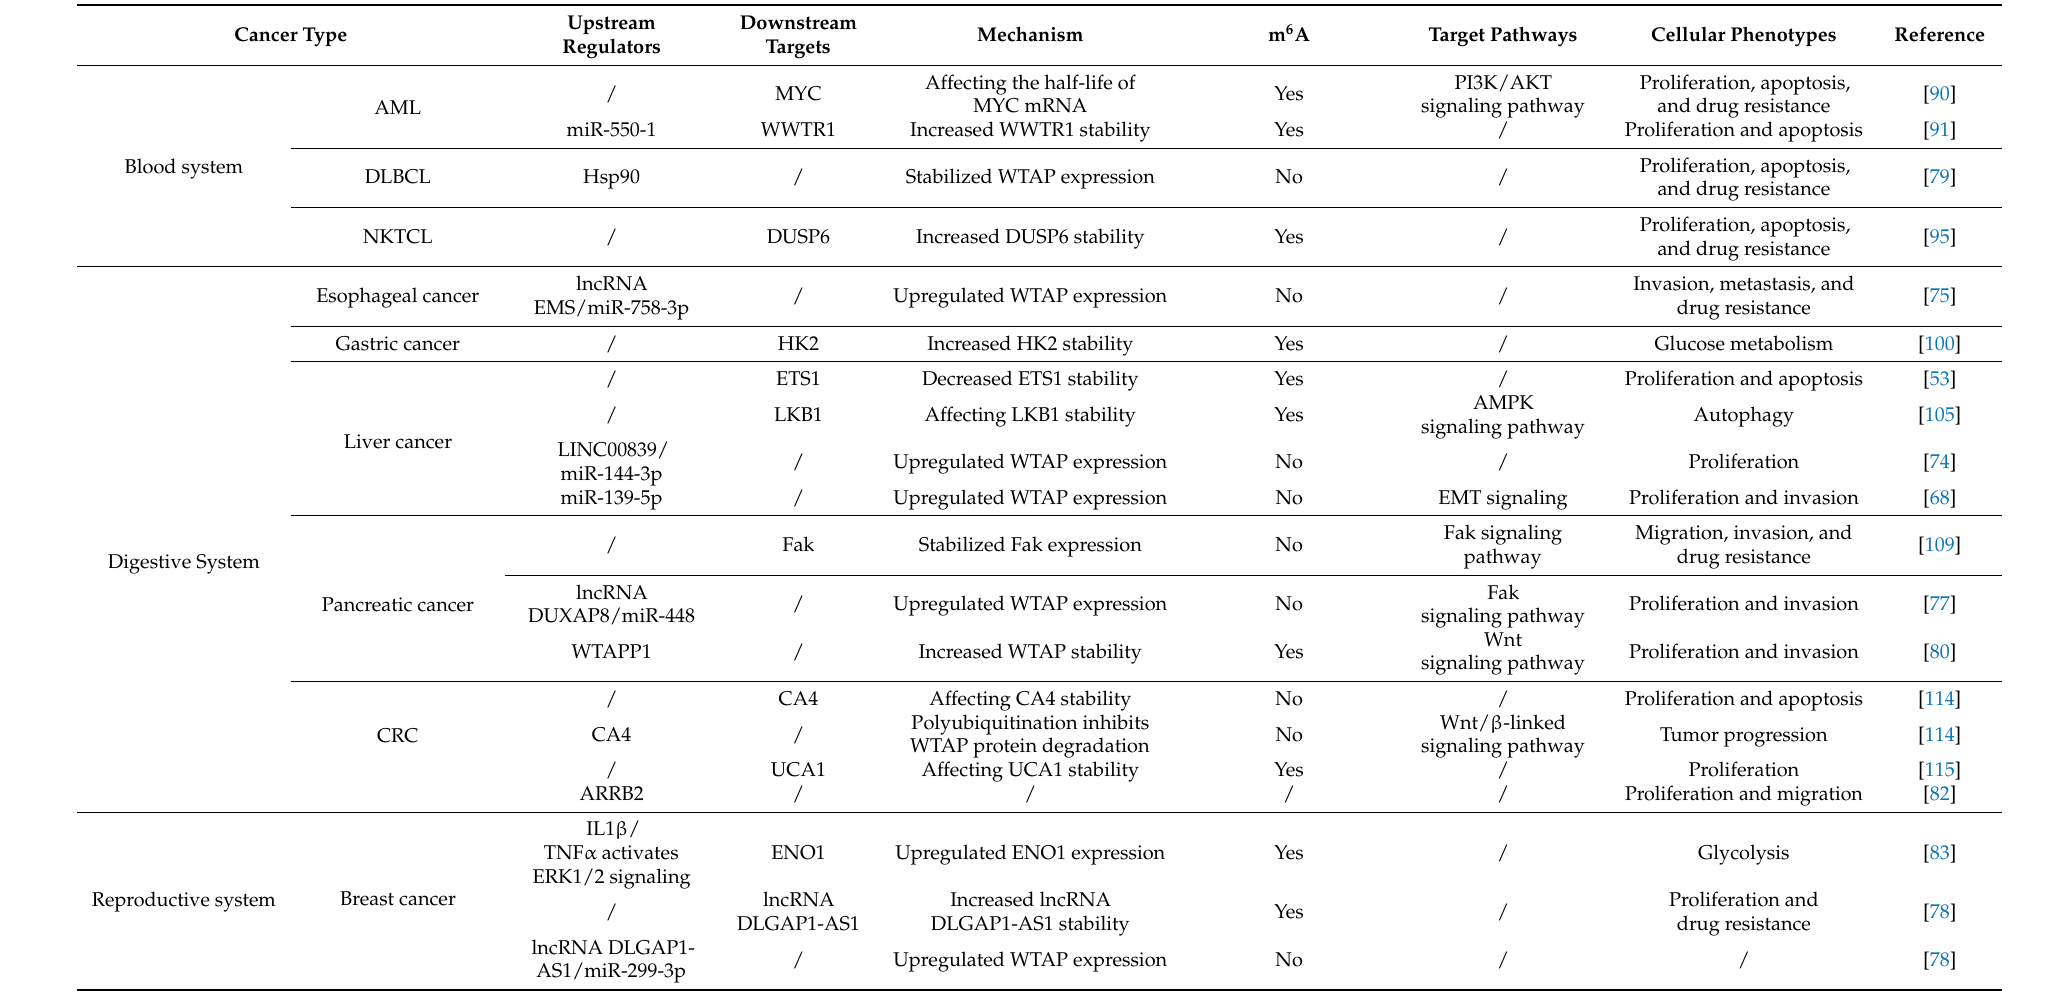
Table 2. Molecular regulatory mechanisms of WTAP in